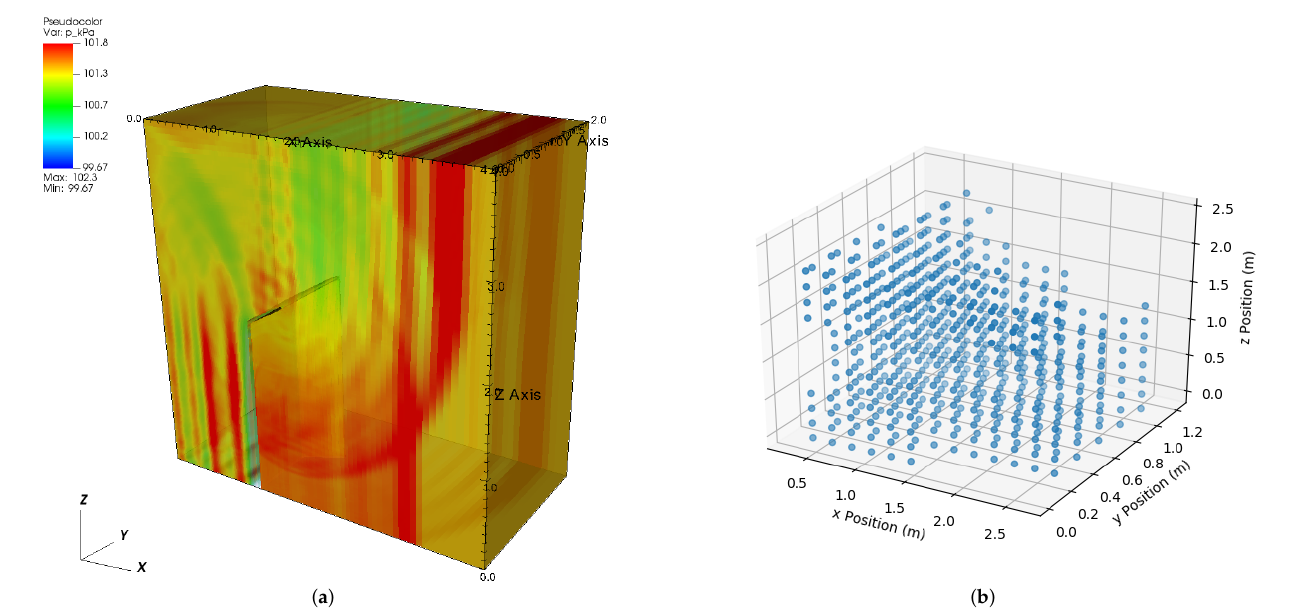
Figure 13. Results from a 3D analysis of a single-fairing mitigation barrier loaded by a wave generated from 0.06123 kg of TNT at approximately 36.576 m. ( a ) A snapshot of the wave reflecting over the barrier. The color gradient is set so that max (red) values are above the 0.4516 kPa overpressure threshold. ( b ) The “bubble” behind the barrier for which max overpressure was beneath 0.4516 kPa.